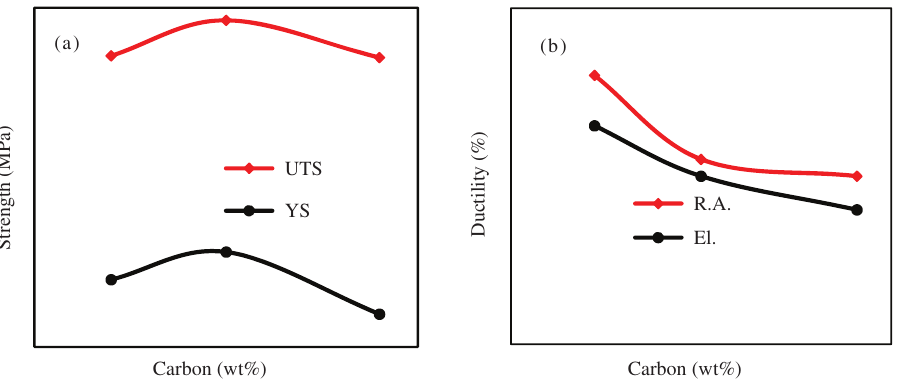
Figure 4: The variation of 650°C (a) tensile strength and (b) ductility of Incoloy 901 alloy with various carbon contents after heat treatment.